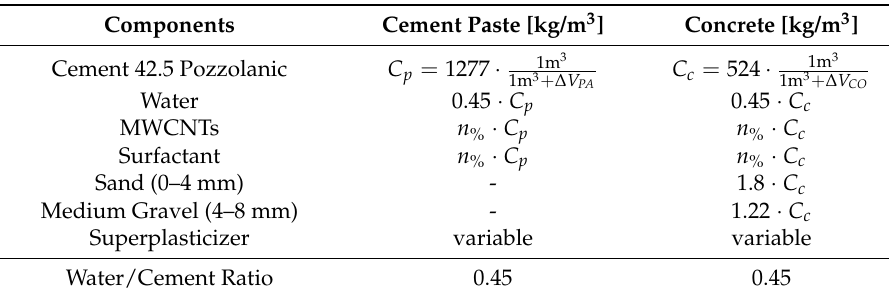
Table 2. Mix design of cement paste and concrete with carbon fillers relative to one cubic meter of self-sensing materials.